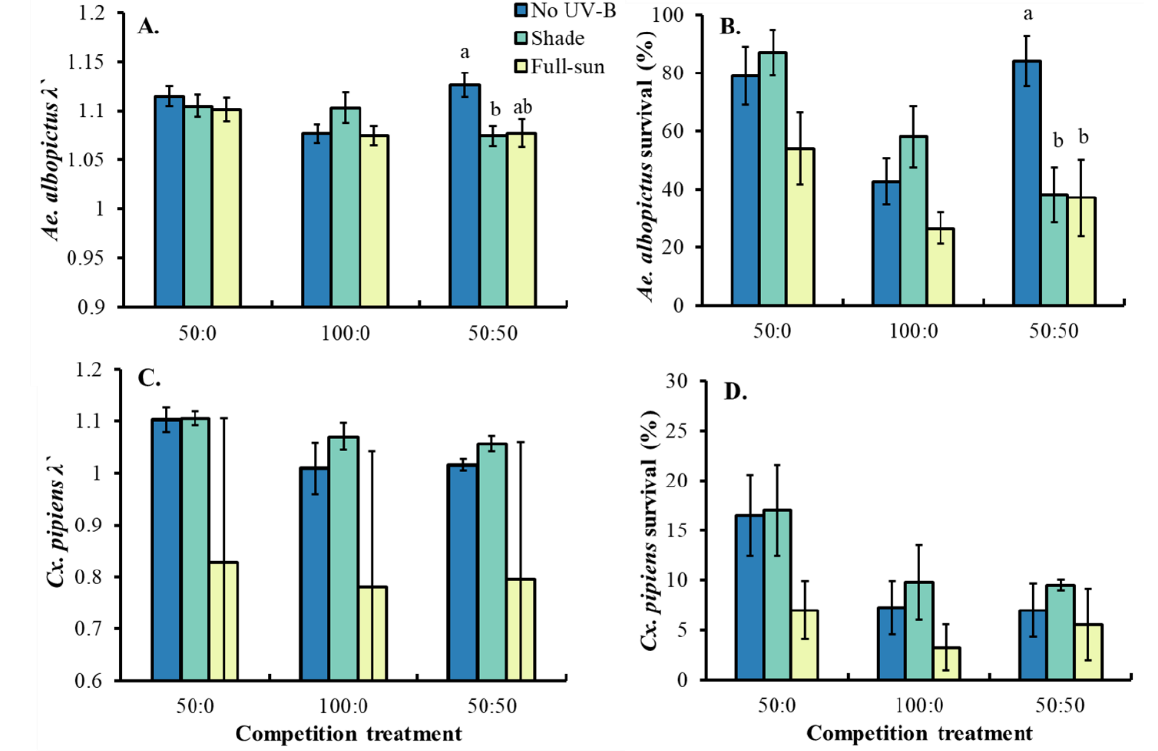
Figure 3. Least square means ( ± SE) of the interaction effects of UV-B radiation (no UV-B, shade, full-sun) and competition treatment (50:0, 100:0, 50:50; conspecifics:heterospecifics) on the estimated